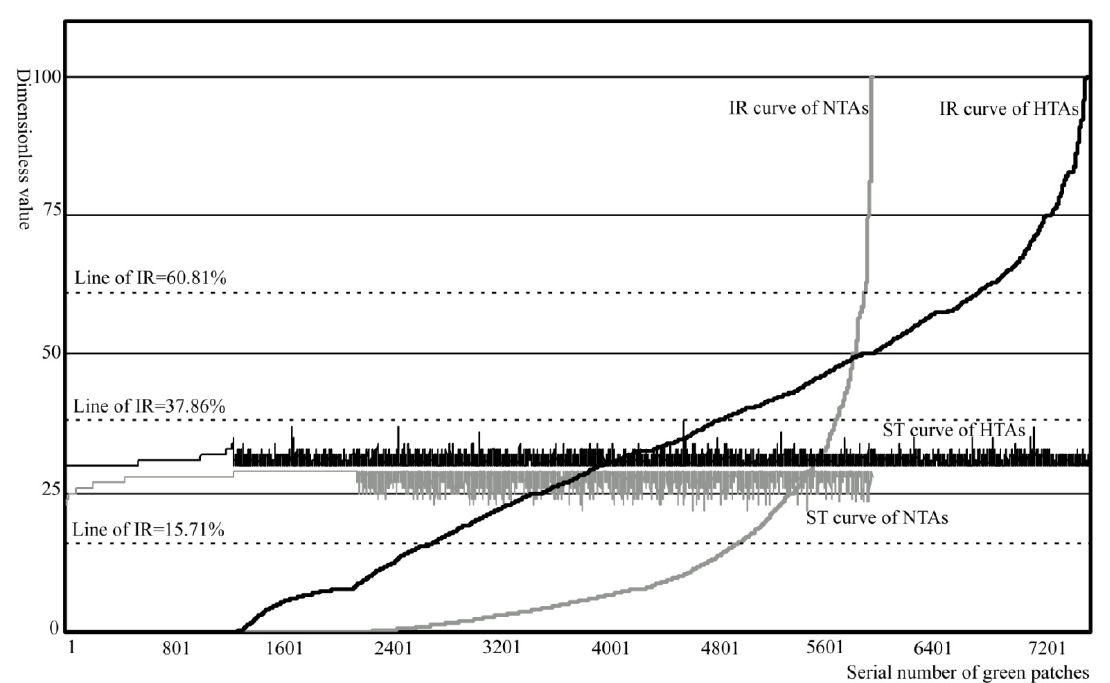
Figure 3. Curves of green ST and IR